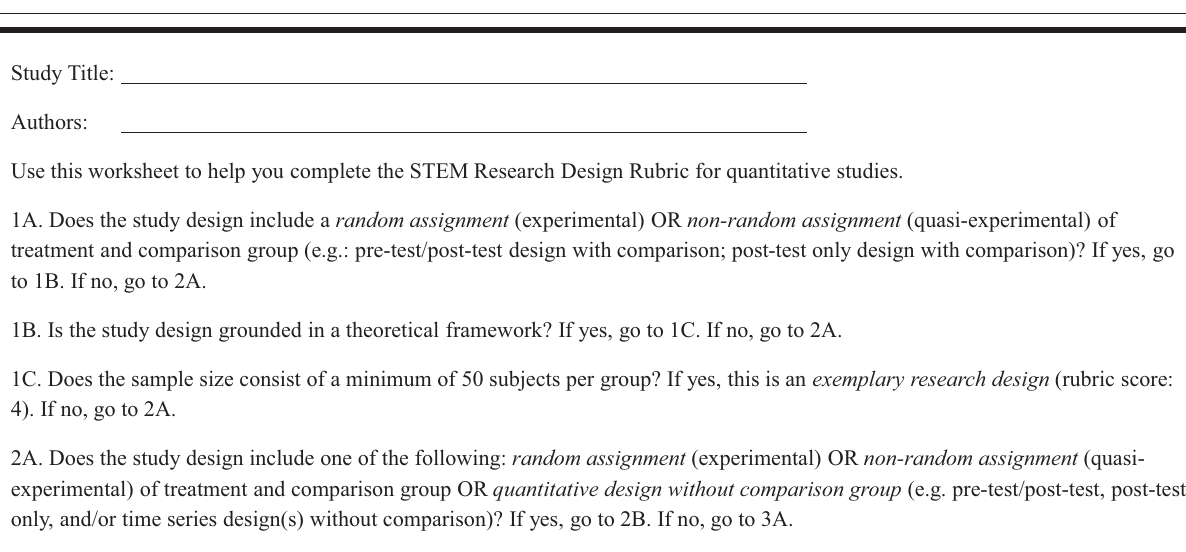
FIGURE 1 | STEM Research Design Rubric worksheet for quantitative studies.